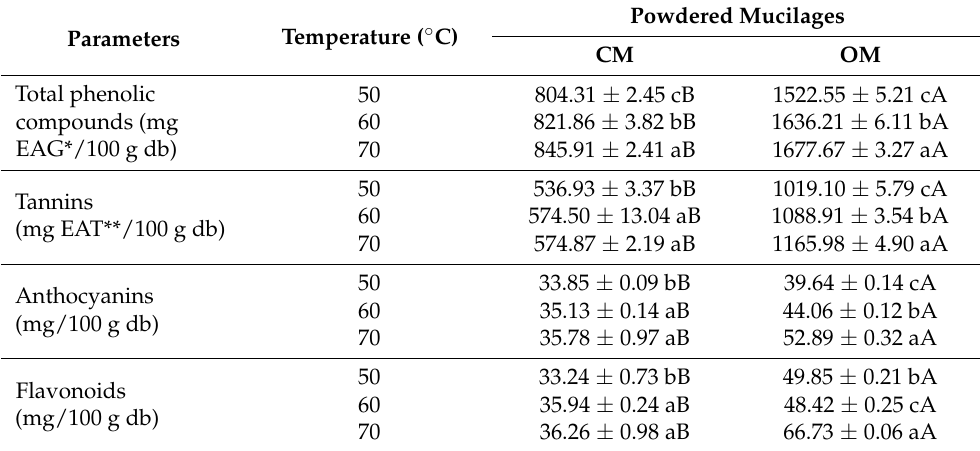
Table 2. Mean values and standard deviations of bioactive compounds in powdered chia (CM) and okra (OM) mucilages obtained at different drying